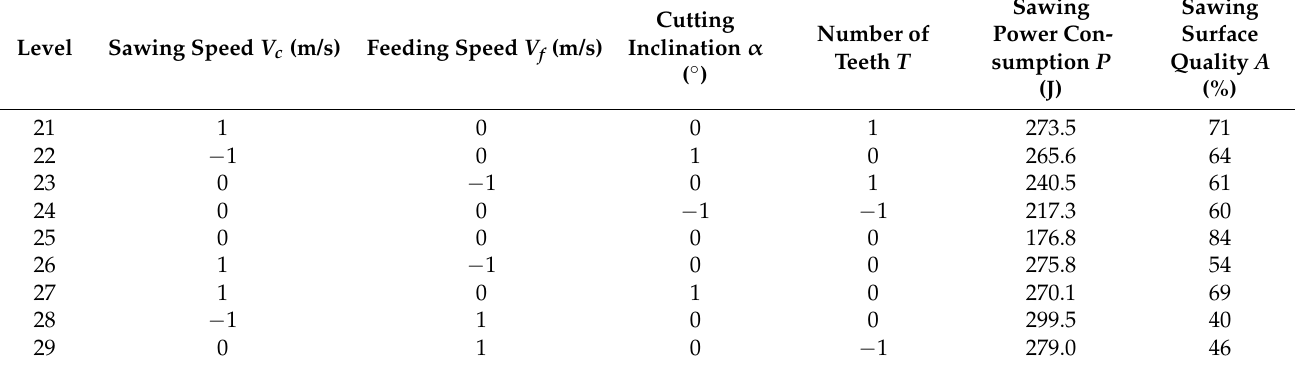
D = 18 mm Figure 13. The surface quality of sawing for different diameters. 6.1.2. Sawing Speed When the sawing speed is less than 35 m/s, the power consumption of sawing will increase significantly, because at the same feeding speed, the lower sawing speed will increase the sawing volume of a single tooth, and the frictional resistance between the saw blade and the branch increases, so that the power consumption of sawing increases and the surface quality of sawing becomes poor. Due to the existence of certain processing and installation errors, when the sawing speed is greater than 45 m/s, it is easy to cause axial vibration of the saw blade, reducing the stability of the saw blade when working, making the cutting power consumption increase, the sawing surface quality poor [47], and the cross-sectional burning phenomenon occur, as shown in Figure 14.